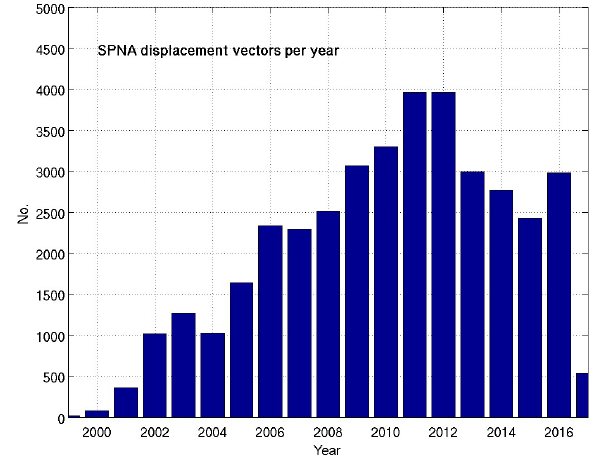
Figure 2. Temporal evolution of the Argo data density in the subpo- lar domain independent of the parking depths (1000 and 1500m), and from year 2000 to March